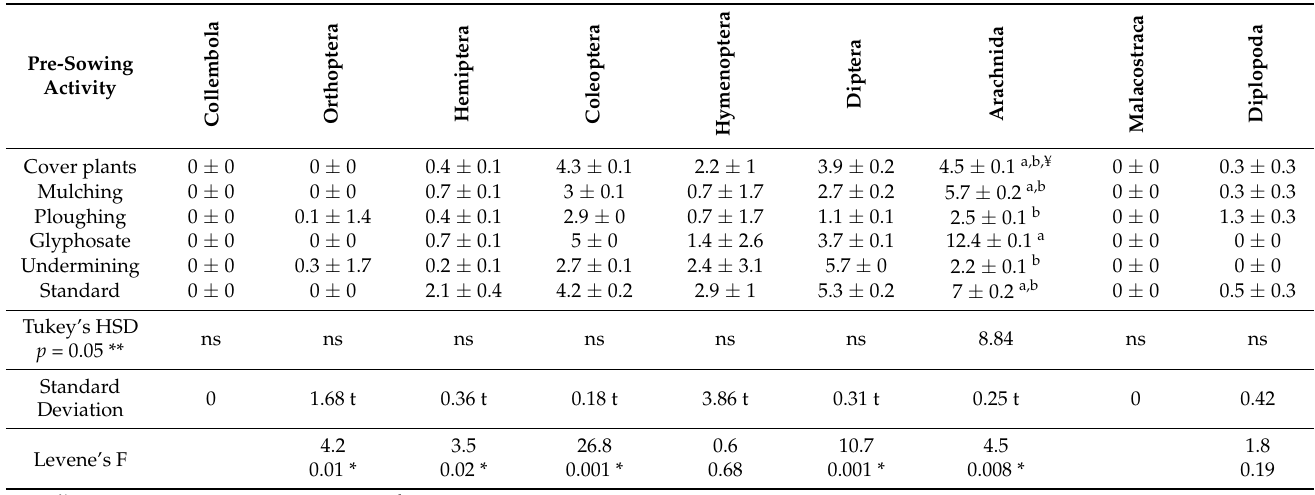
Table 7. Total soil fauna analysed by order/class ( ± SE) collected in September on different tillage systems before sowing.